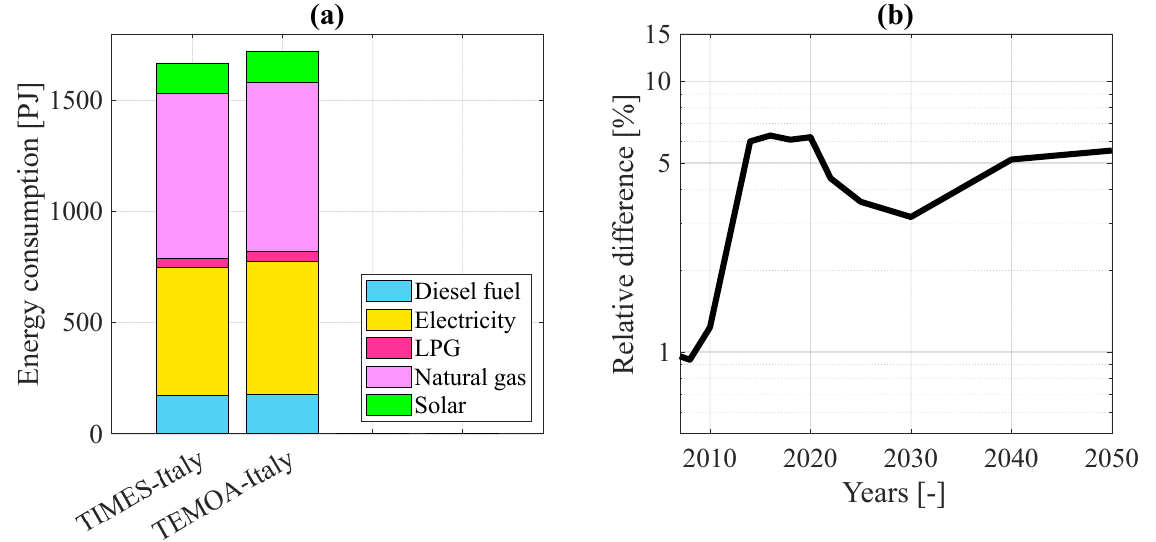
Figure 13. Comparison between the optimal buildings energy mix: ( a ) composition in 2030; ( b ) average relative difference curve along the time.